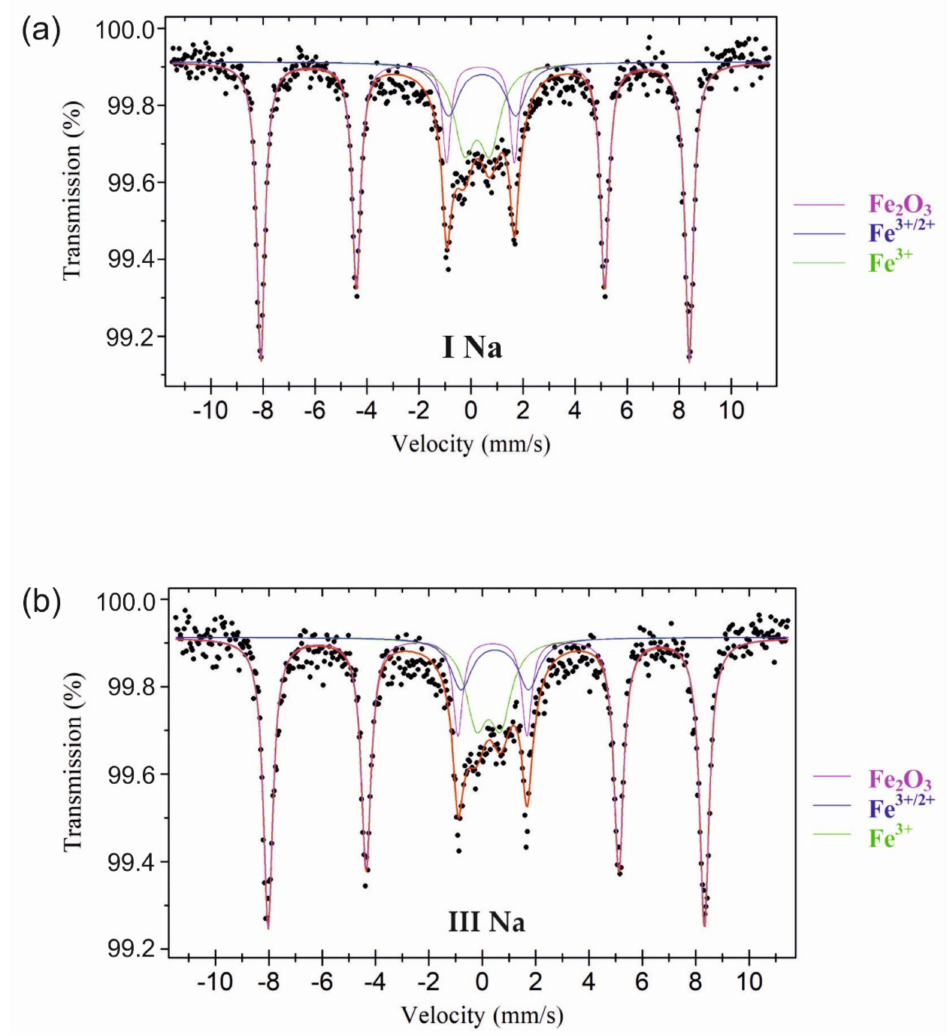
Figure 5. Room temperature Mössbauer spectra of the sodium-rich samples heat-treated at 1200 ◦ C. ( a ) I Na doped with Fe 2 O 3 , ( b ) III Na doped with Fe 2 O 3 + TiO 2